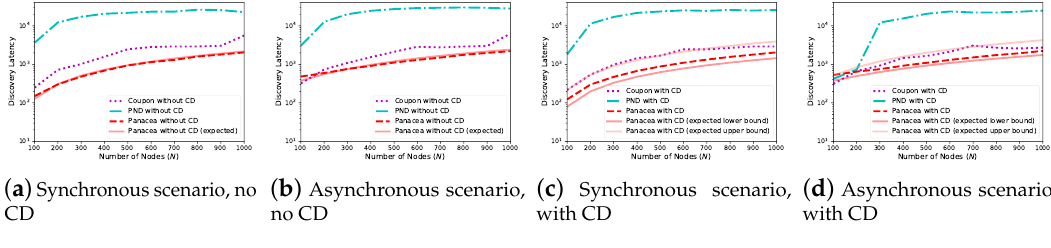
Figure 4. Panacea -NCD and Panacea -WCD achieve lowest discovery latency for both synchronous and asynchronous scenarios when p n = 0.1 and N increases from 100 to